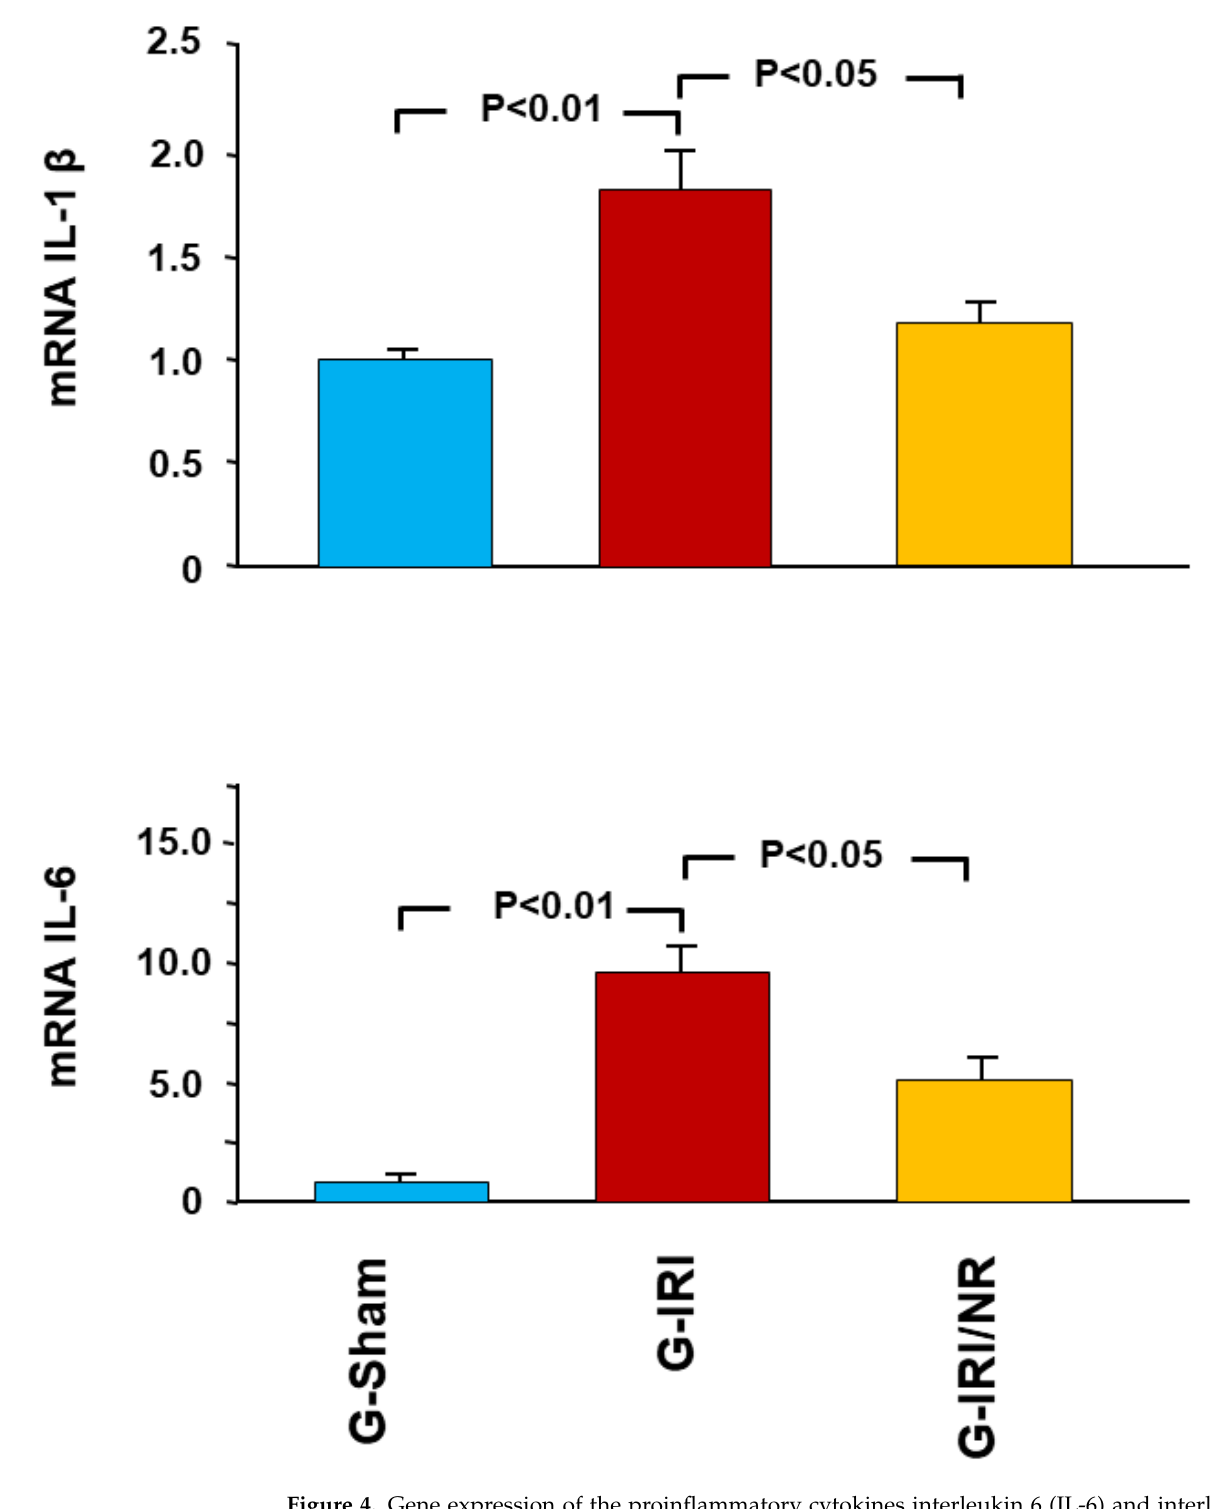
Figure 4. Gene expression of the proinflammatory cytokines interleukin 6 (IL-6) and interleukin 1 beta (IL-1 β ) in all groups. Values represent mean ± SEM.